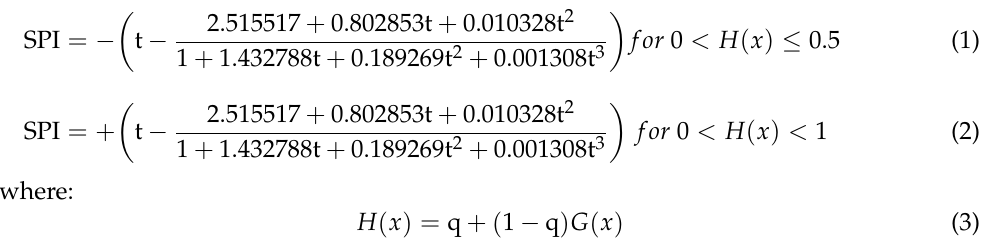
tween 1990 and 2019 (right graph).